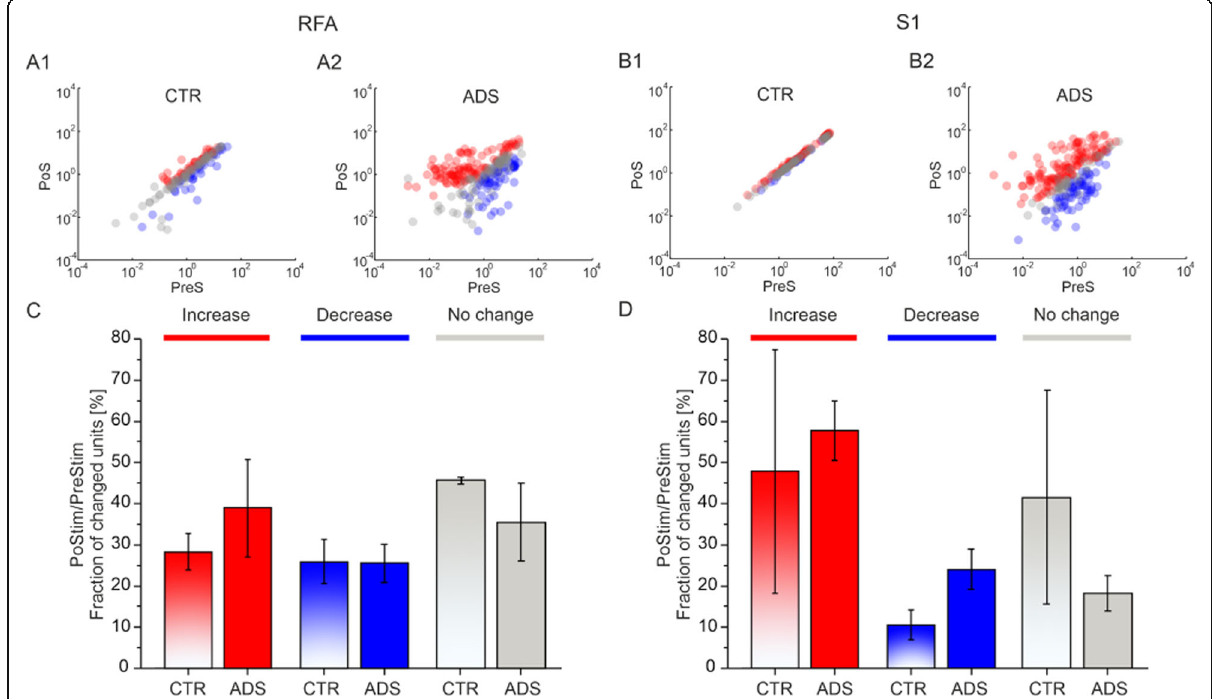
Fig. 5 Effect of the stimulation on the firing units: ADS vs CTR. On the left, data for RFA area. In A1) for CTR and A2) for ADS, per unit correlation between baseline firing rates (x-axis, PreStim - PreS) and firing rates after the stimulation session (y-axis, PostStim - PoS). Data is shown in scatter plots where colors represent units that increased (red), decreased (blue), or remained stable (light grey). In C) for both CTR (shaded bars) and ADS, average fraction of units that increased (red), decreased (blue) or no changed (grey) their firing with respect to the baseline period of recording (i.e. PreStim - PreS) calculated for the immediately post stimulation phase (i.e. PostStim - PoS). Data are reported as mean ± SEM (standard error of the mean). Statistics. The same representations are on the right for S1 area. In B1) left sketch CTR and B2) right sketch ADS and in D) the average fraction of units that changed their firing in both CTR and